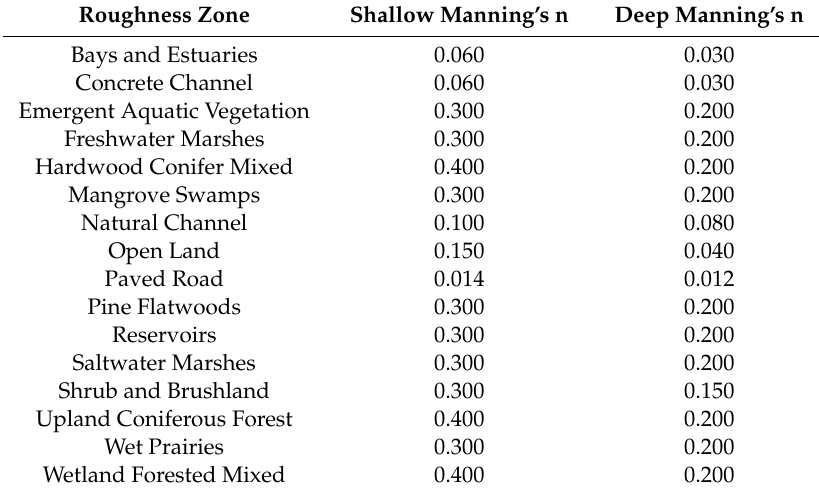
Table 2. Shallow and deep Manning’s roughness coe ffi cient (n) for 2D surface model (based on Chow [31] and TR-55 [29]). Roughness